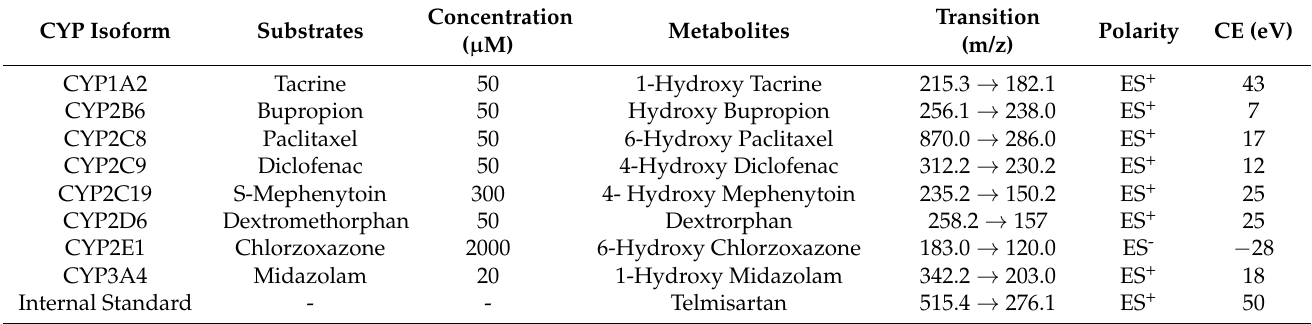
Table 1. Substrates, their metabolites, and their LC-MS/MS conditions of the reaction for CYPs using cocktail assays. CYP